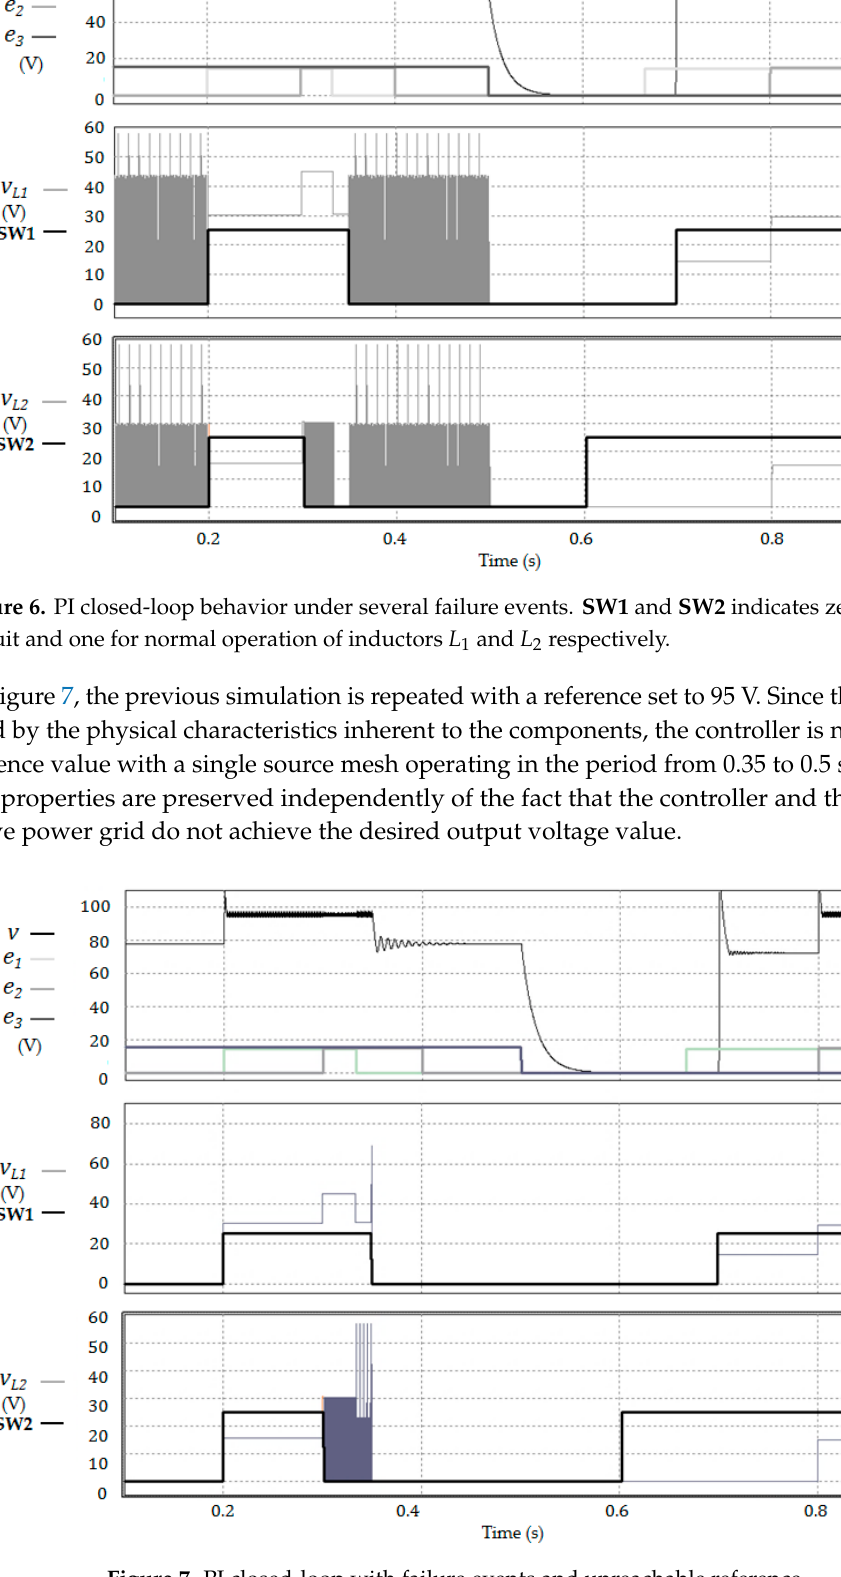
Figure 8. Series-connected boost converters [30,31].